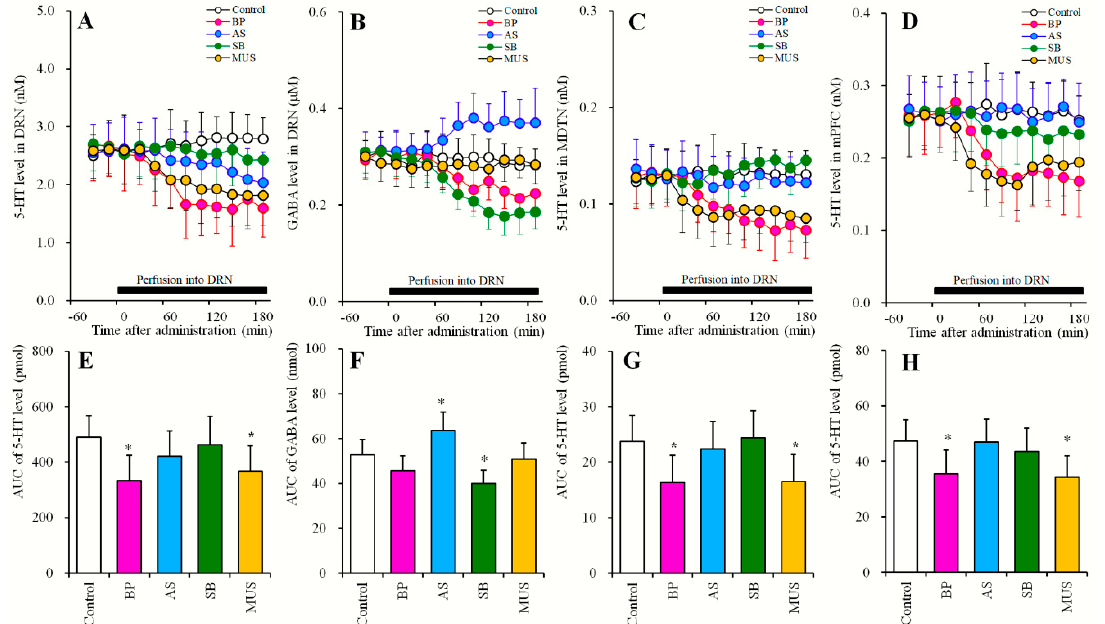
Figure 4. E ff ects of local administration of BP554, AS19, SB269970 and muscimol into the DRN on extracellular levels of 5-HT in the DRN, MDTN, mPFC, and GABA in the DRN (Study_3-2). ( A , C , D ) indicate e ff ects of perfusion with 1-[3-(3,4-Methylenedioxyphenoxy) propyl]-4-phenyl- piperazine (BP: 50 µ M), (2S)-( + )-5-(1,3,5- Trimethylpyrazol-4-yl)-2- (dimethylamino)tetralin (AS: 1 µ M), (2R)-1-[(3-Hydroxyphenyl)sulfonyl]- 2-[2-(4-methyl-1- piperidinyl)ethyl]pyrrolidine (SB: 10 µ M) and muscimol (MUS: 1 µ M) on extracellular levels of 5-HT in the DRN, MDTN and mPFC, respectively. ( B )indicatese ff ectsofperfusionwithBP554, AS19, SB269970andmuscimolintotheDRNonextracellular GABA levels in the DRN. Y -axis: Mean ± SD (n = 6) of extracellular levels of 5-HT (nM) and GABA ( µ M); X -axis: Time after administration of target agents (min). Closed bars indicate perfusion with target agents into the DRN. Microdialysis was conducted to measure the releases of 5-HT and GABA. ( E – H ) indicate the AUC value of extracellular levels of 5-HT (pmol) and GABA (nmol) during perfusion with target agents from 20 to 180 min of ( A – D ), respectively. Opened, pink, light blue, green and orange columns represent the AUC values of perfusion with control, BP554, AS19, SB269970 and muscimol, respectively. * P < 0.05; relative to control by MANOVA with Tukey’s post hoc